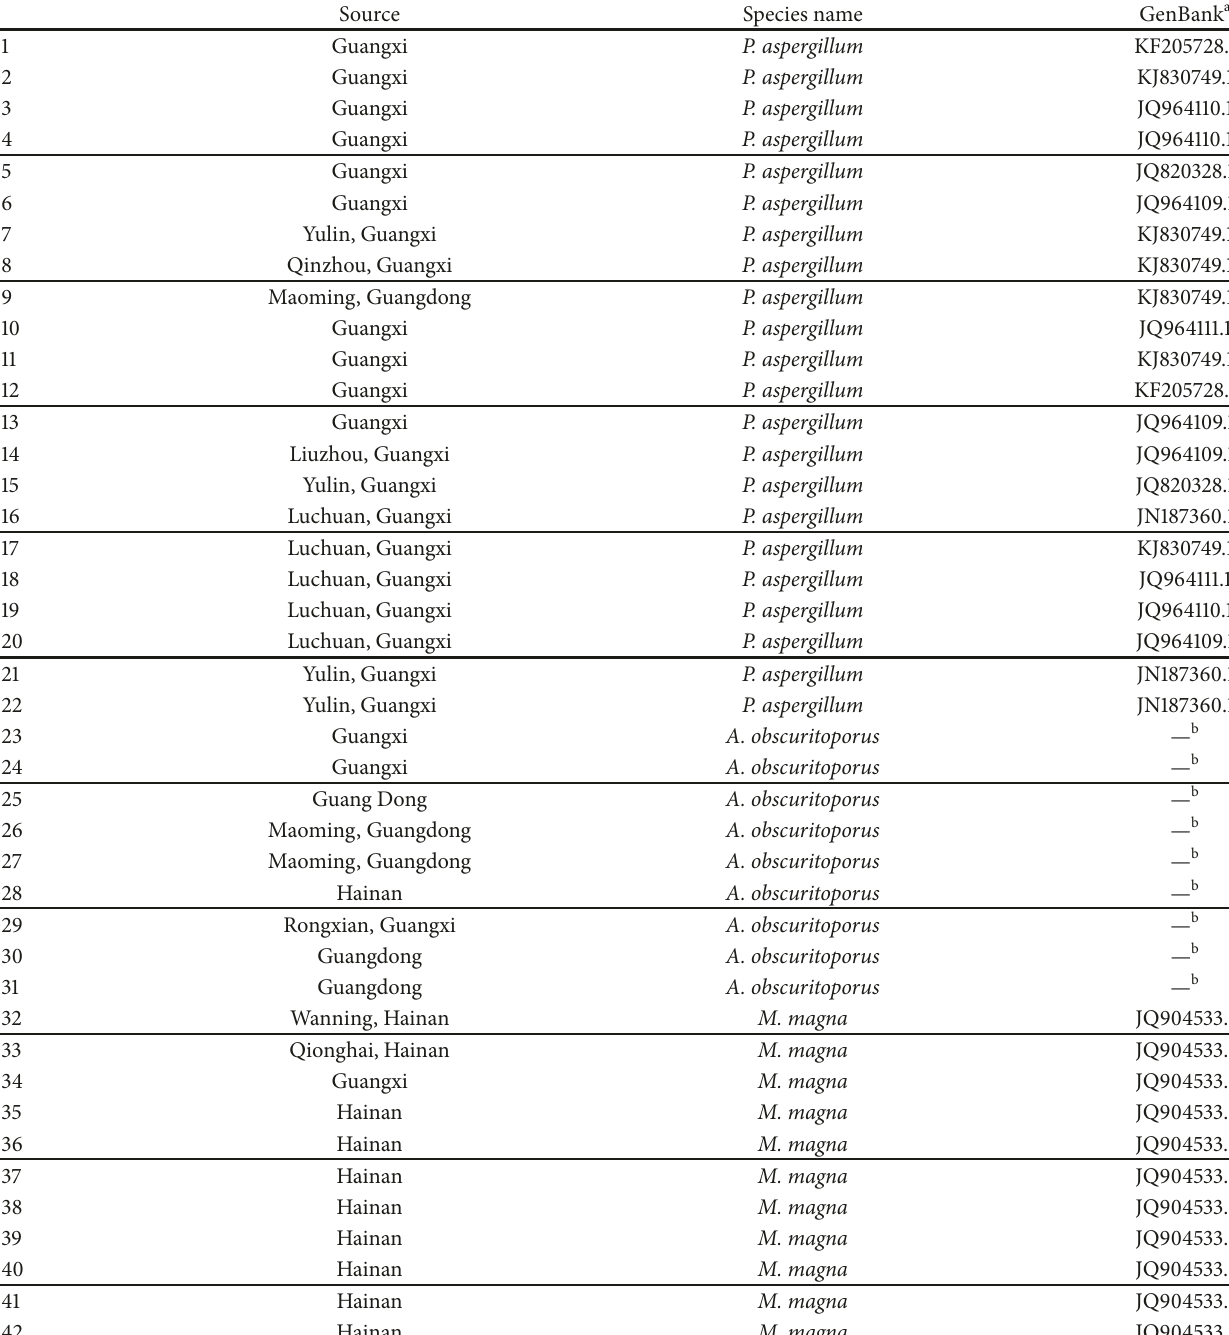
Table 1: Sources of commercial Guang Dilong with PCR identification results (GenBank Accession